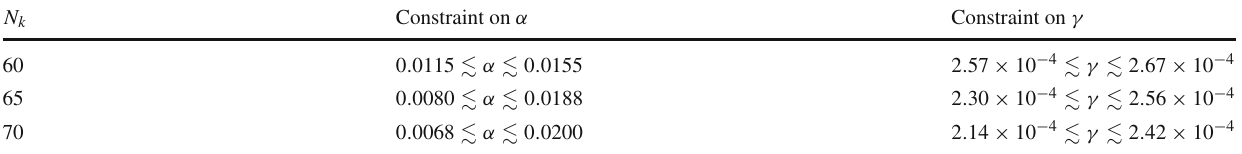
Table 8 Results of the constraints on the parameters α and γ for Higgs-like inflation in the high-energy limit of the Randall–Sundrum brane model, using the last data of PLANCK N k